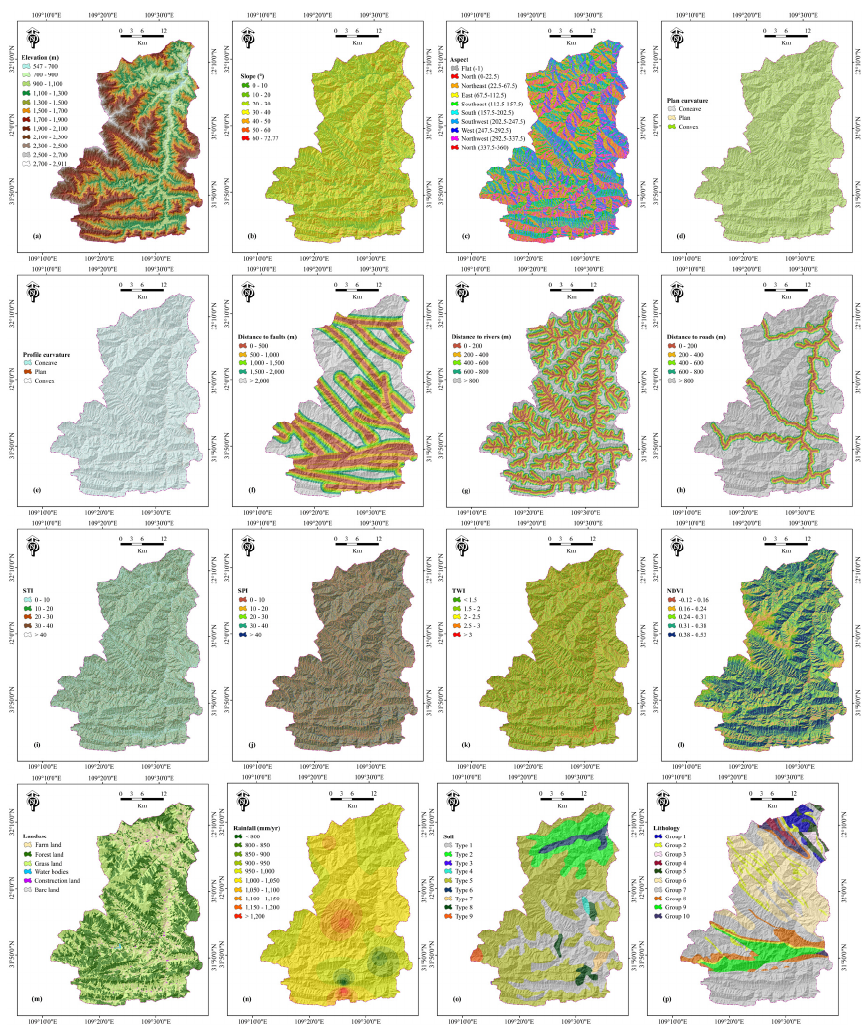
Figure 2. Landslide conditioning factor maps: ( a ) elevation; ( b ) slope; ( c ) aspect; ( d ) plan curvature; ( e ) profile curvature; ( f ) distance to faults; ( g ) distance to rivers; ( h ) distance to roads; ( i ) sediment transport index (STI); ( j ) stream power index (SPI); ( k ) topographic wetness index (TWI); ( l ) normalized difference vegetation index (NDVI); ( m ) land use; ( n ) rainfall; ( o ) soil; ( p ) lithology.